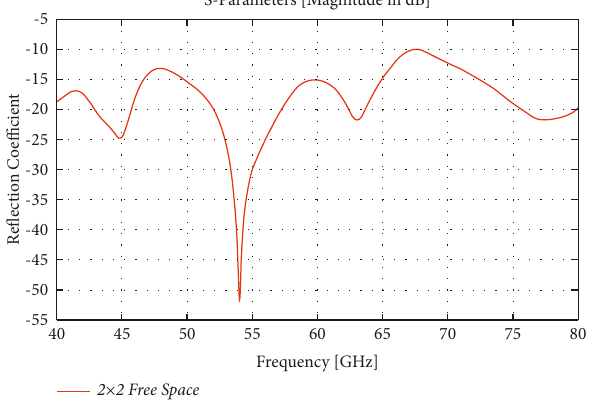
Figure 25: Return loss of the 2 × 2 antenna array.